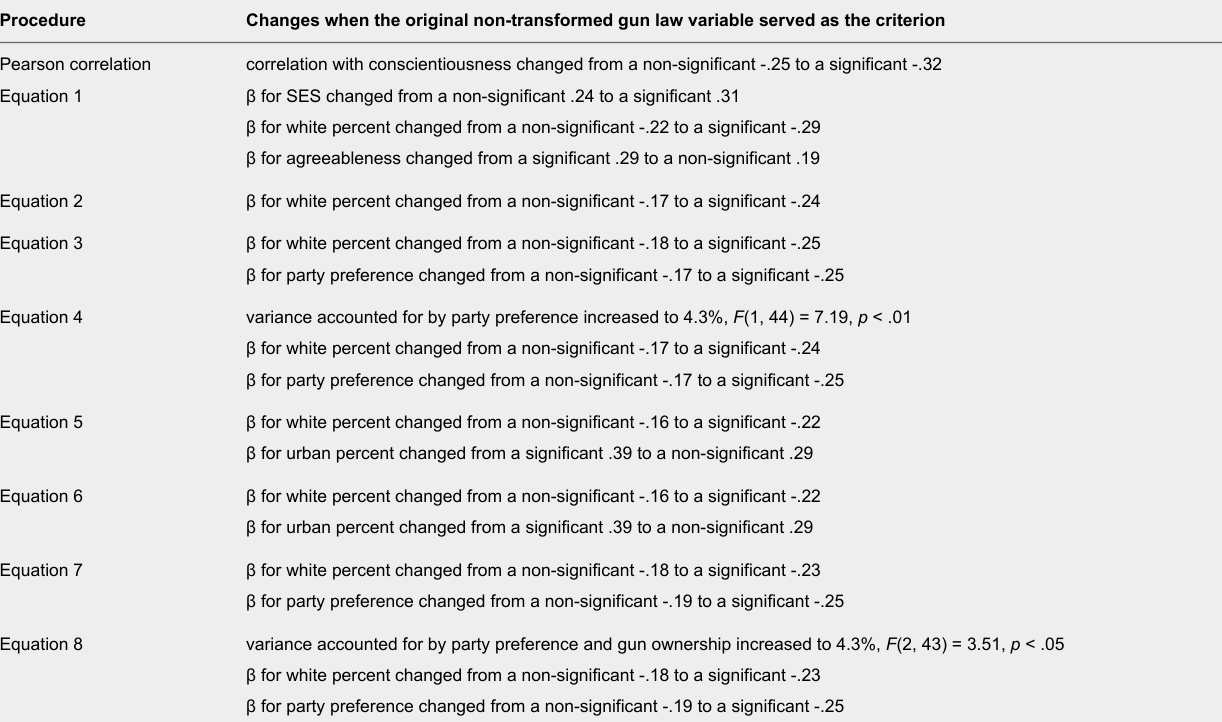
Substantive Changes From the Original Results With the Non-Transformed Gun Law Variable as the Criterion Changes when the original non-transformed gun law variable served as the criterionProcedure correlation with conscientiousness changed from a non-significant -.25 to a significant -.32Pearson correlation β for SES changed from a non-significant .24 to a significant .31Equation 1 β for white percent changed from a non-significant -.22 to a significant